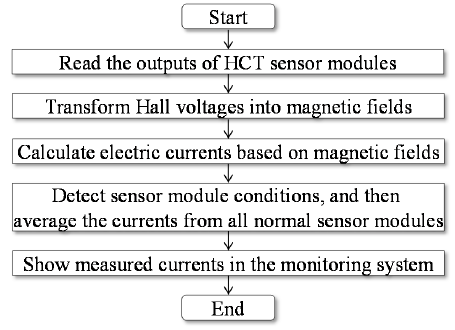
Figure 7. Flowchart of current measurement function unit.